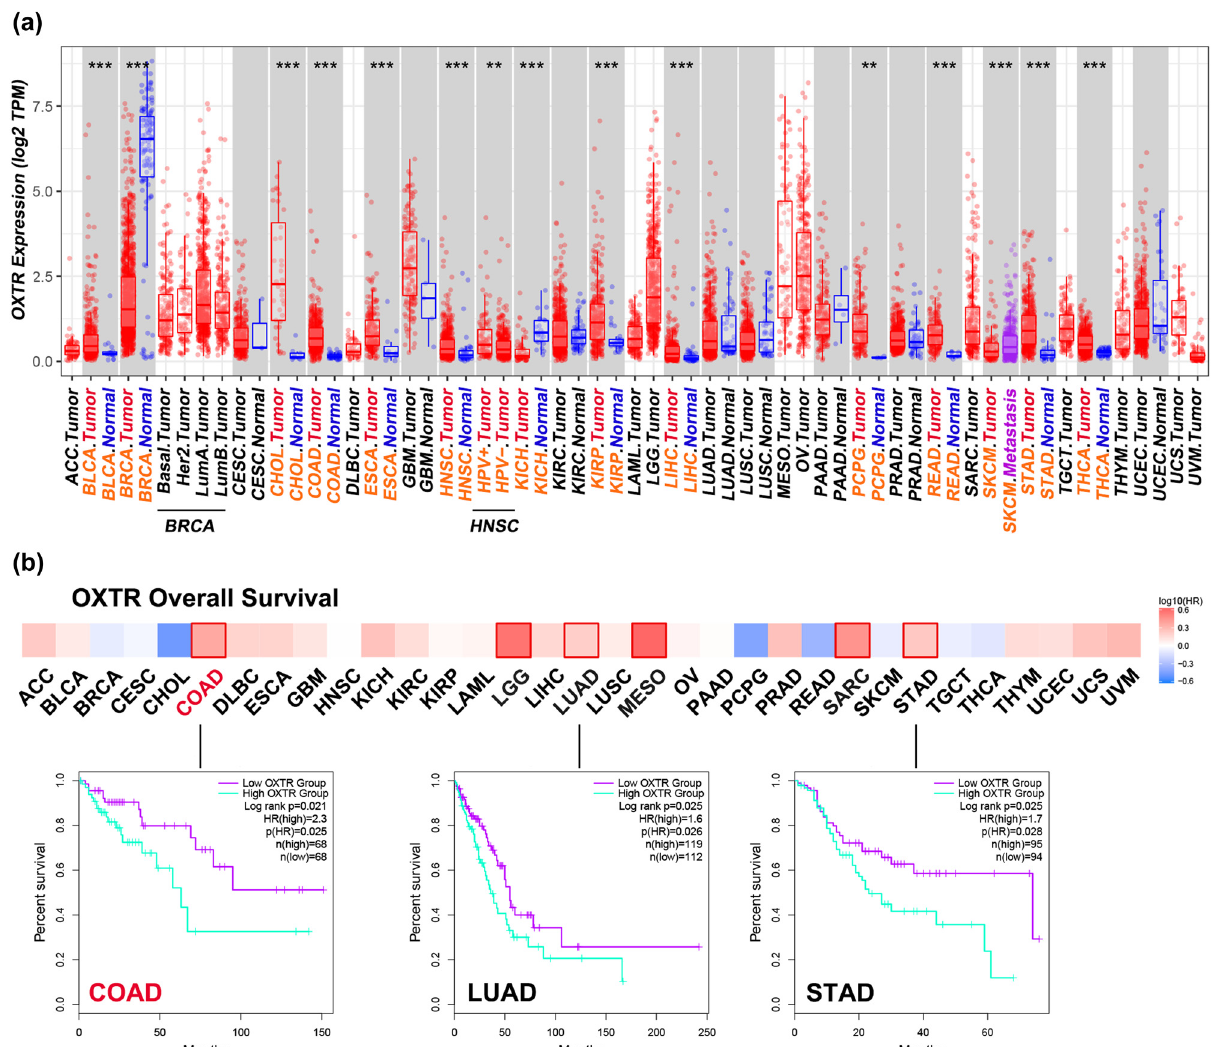
Figure 1: Analysis of OXTR expression in various tumor tissues in TCGA. ( a ) Transcriptional levels of OXTR in di ff erent tumor tissues and adjacent normal tissues. ( b ) The relationships between OXTR expression levels in various tumors and OS were analyzed by KM curve. COAD: low OXTR group: n = 68, high OXTR group: n = 68; LUAD: low OXTR group: n = 112, high OXTR group: n = 119; STAD: low OXTR group: n = 94, high OXTR group: n = 95. ACC: adrenocortical carcinoma; BLCA: bladder urothelial carcinoma; BRCA: breast invasive carcinoma; CESC: cervical squamous cell carcinoma and endocervical adenocarcinoma; CHOL: cholangiocarcinoma; COAD: colon adenocarcinoma; DLBC: lymphoid neoplasm di ff use large B - cell lymphoma; ESCA: esophageal carcinoma; GBM: glioblastoma multiforme; HNSC: head and neck squamous cell carcinoma; HPV: human papillomavirus; KICH: kidney chromophobe; KIRC: kidney renal clear cell carcinoma; KIRP: kidney renal papillary cell carcinoma; LAML: acute myeloid leukemia; LGG: brain lower grade glioma; LIHC: liver hepatocellular carcinoma; LUAD: lung adenocarcinoma; LUSC: lung squamous cell carcinoma; MESO: mesothelioma; OV: ovarian serous cystadenocarcinoma; PAAD: pan - creatic adenocarcinoma; PCPG: pheochromocytoma and paraganglioma; PRAD: prostate adenocarcinoma; READ: rectum adenocarcinoma; SARC: sarcoma; SKCM: skin cutaneous melanoma; STAD: stomach adenocarcinoma; TGCT: testicular germ cell tumors; THCA: thyroid carcinoma; THYM: thymoma; UCEC: uterine corpus endometrial carcinoma; UCS: uterine carcinosarcoma; UVM: uveal melanoma; LumA: luminal A; LumB: luminal B; Her2: human epidermal growth factor receptor - 2. **: p < 0.01; ***: p <